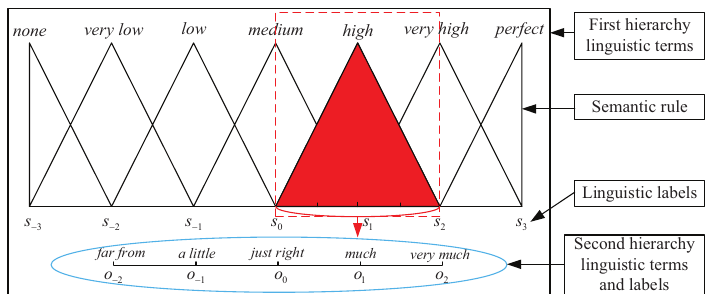
Figure 2. The second hierarchy LTS of a linguistic term in the first hierarchy LTS